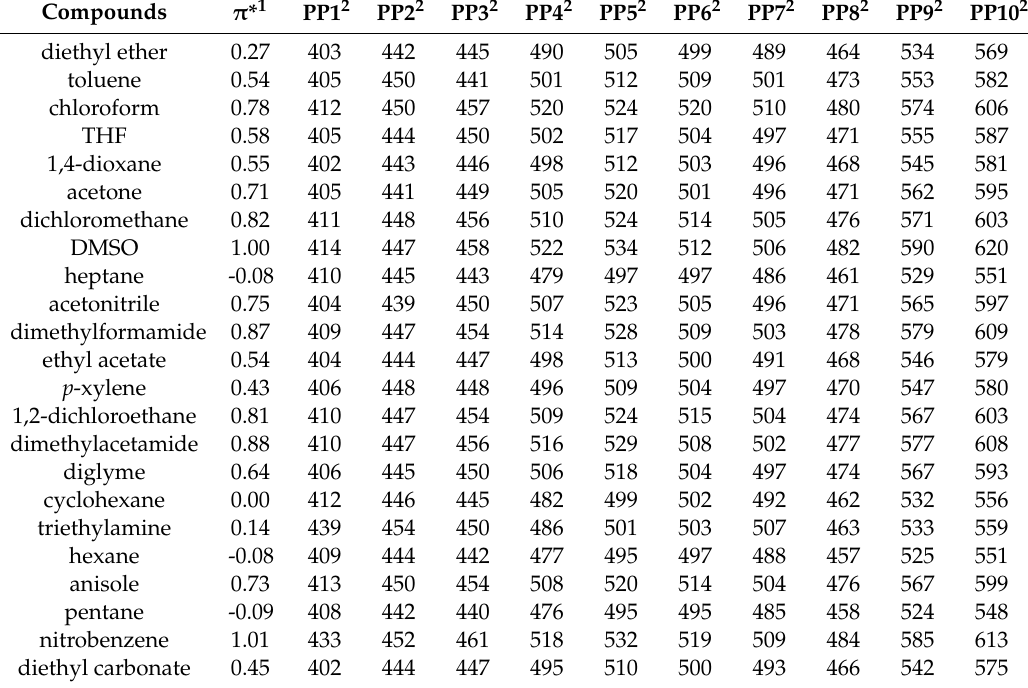
Table 3. Summary of the optical properties of PP1 – PP10 in twenty-three solvents and Kamlet and Taft parameters π *.